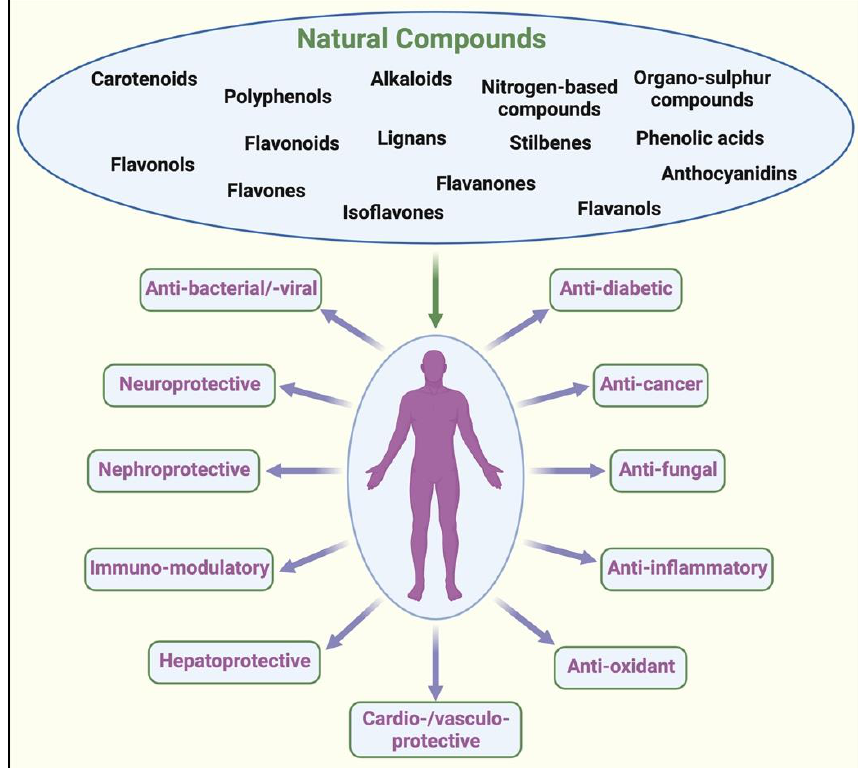
Figure 1. Pharmacological effects of natural compounds in various diseases. Naturally derived compounds have been used for their anti-oxidant, anti-diabetic, anti-cancer, anti-microbial, anti-inflammatory, immuno-modulatory, cardio-/vasculo-/hepato-/nephro-, and neuro-protective effects. Created with BioRender.com